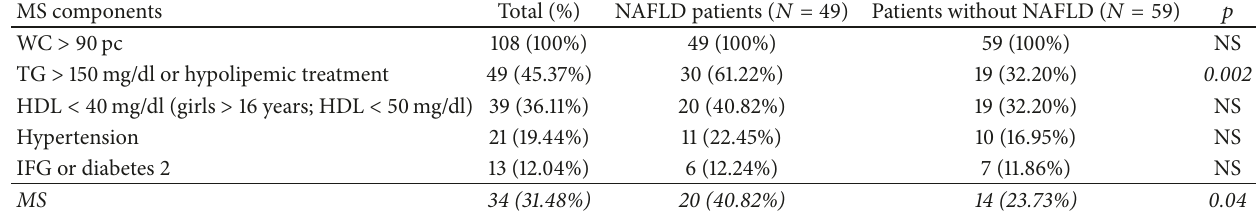
Table 5: Prevalence of metabolic factors in NAFLD and non-NAFLD group.